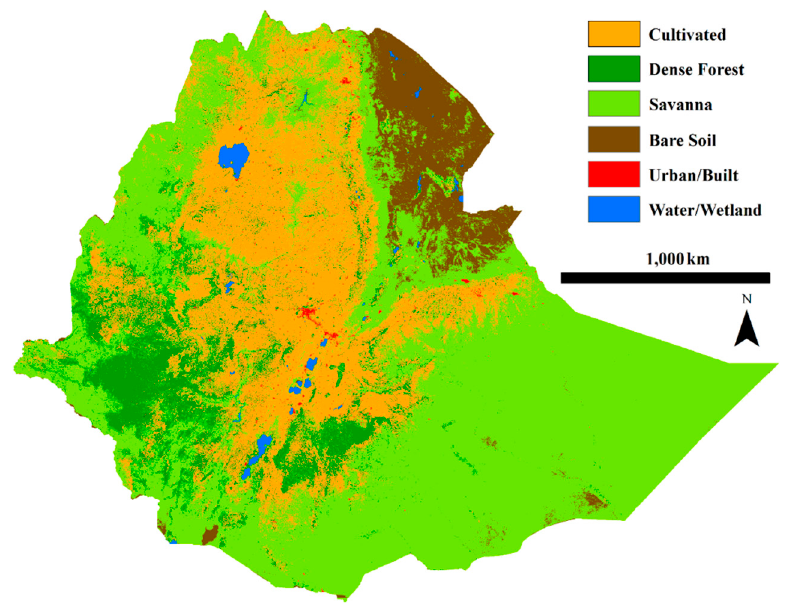
Figure 4. Land-cover map of Ethiopia for 2017 at 30 m spatial resolution.